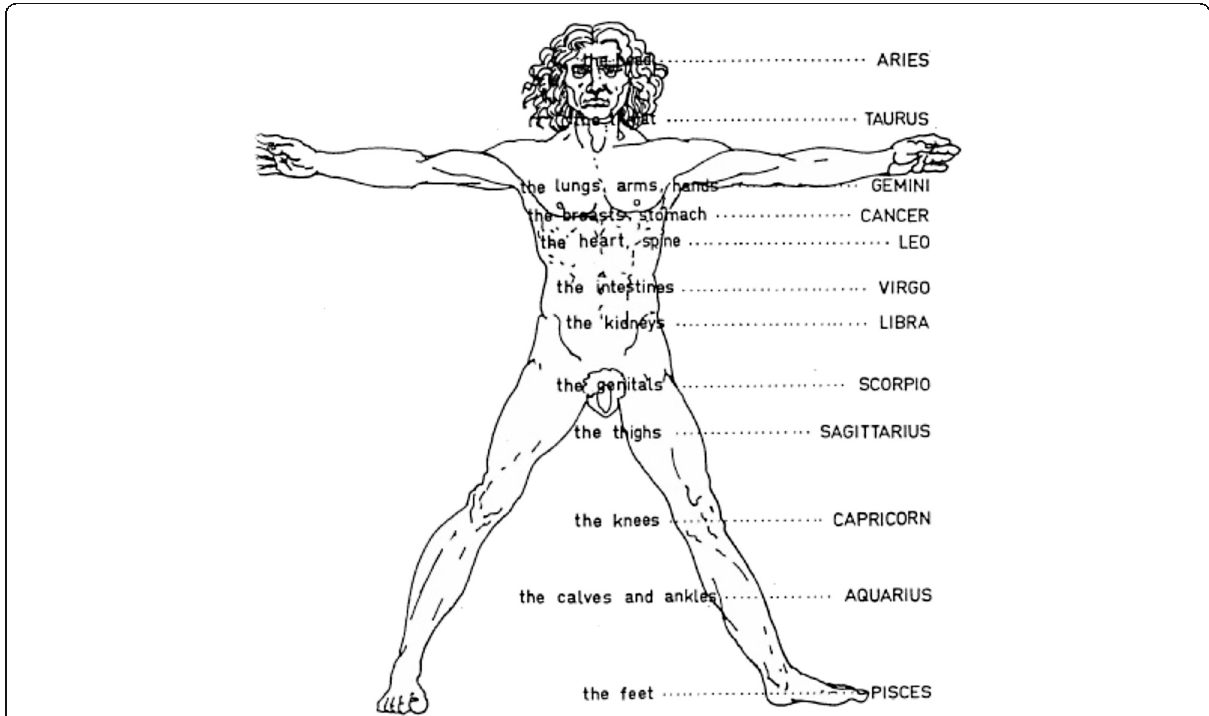
Fig. 1 Anatomical-astrological human (drawing by © Alla Mikhailova). According to medical astrology, each organ (or organ system) is associated with a certain moon sign. Note, that the kidneys are assigned to the sign of